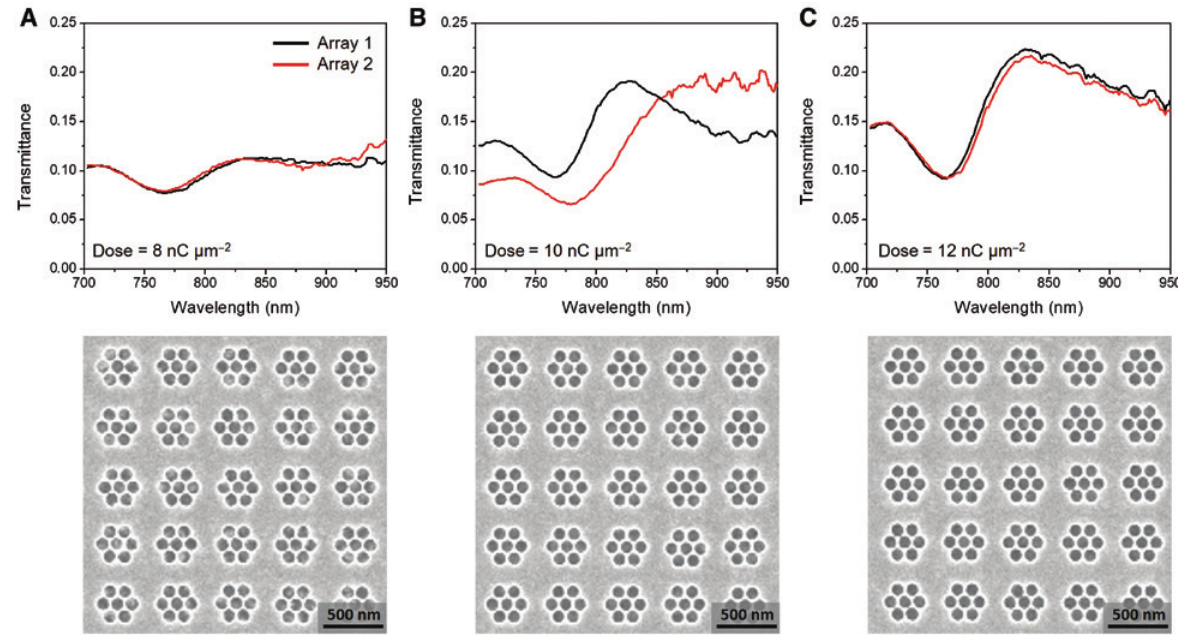
Figure 4: Optical transmittance responses (top) and SEM images (bottom) of HNH arrays fabricated by direct HeFIB milling at the milling dose of (A) 8 nC μ m −2 , (B) 10 nC μ m −2 , and (C) 12 nC μ m −2 . The black and red curves are measurements for repeated fabrication